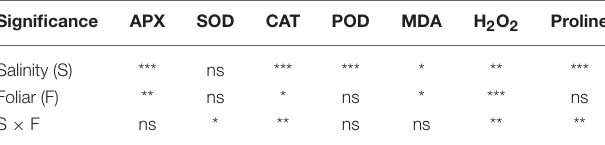
TABLE 5 | Effect of salinity levels (0–25–50–100mM NaCl) and foliar applications (no foliar, K, Zn, and Si) on the damage index and antioxidant enzymes activities in lavender grown hydroponically in perlite.